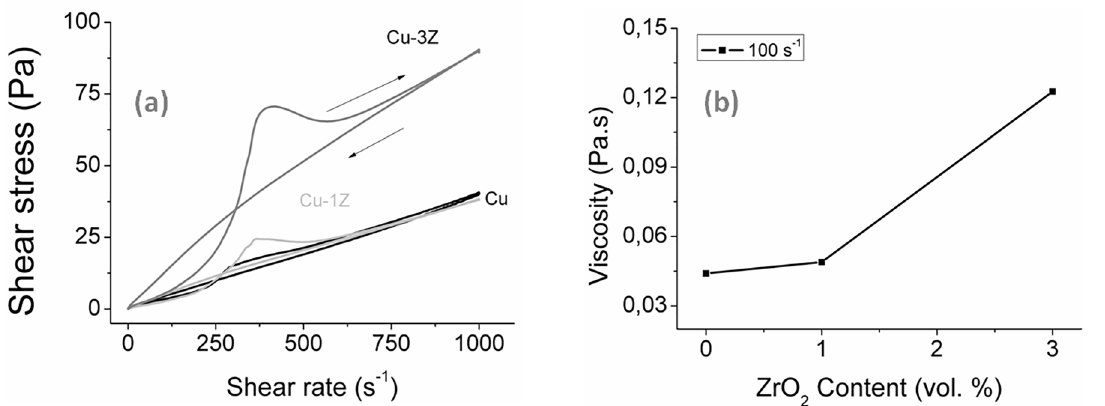
aqueous suspensions with a solids content of 58 vol.% (a) and viscosity at a shear rate of Figure 1. CR flow curves of Cu and Cu-ZrO 2 100 s -1 of the suspensions as a function of zirconia volume content